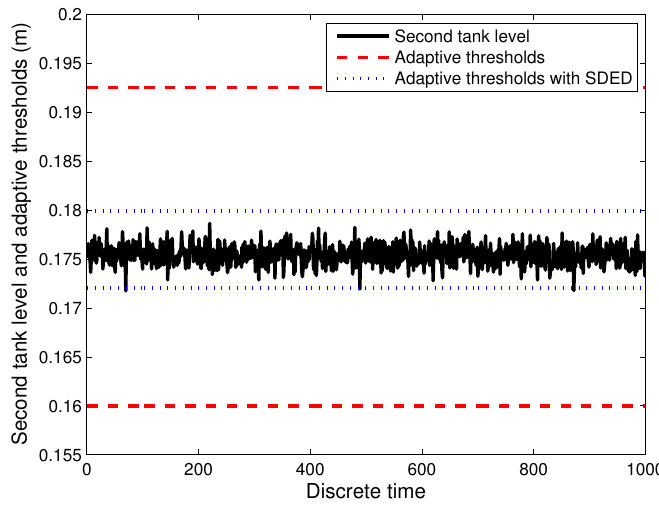
Figure 15. Second tank level and the corresponding adaptive thresholds obtained with and without